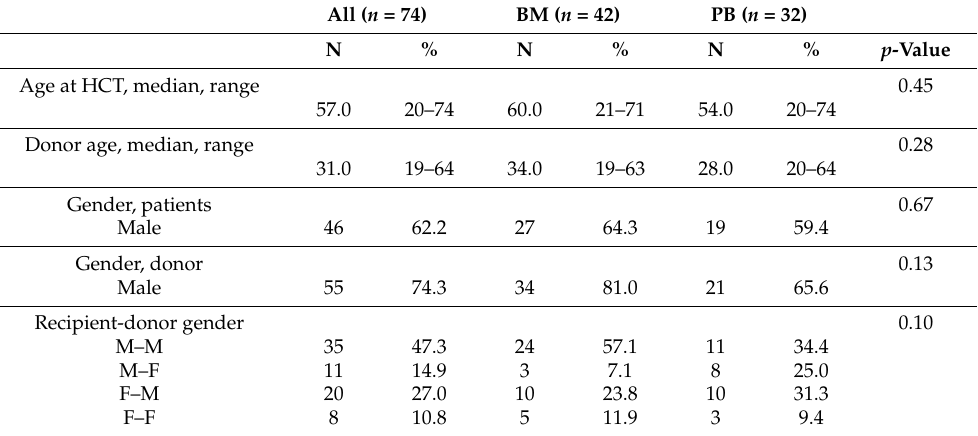
Table 1. Patient